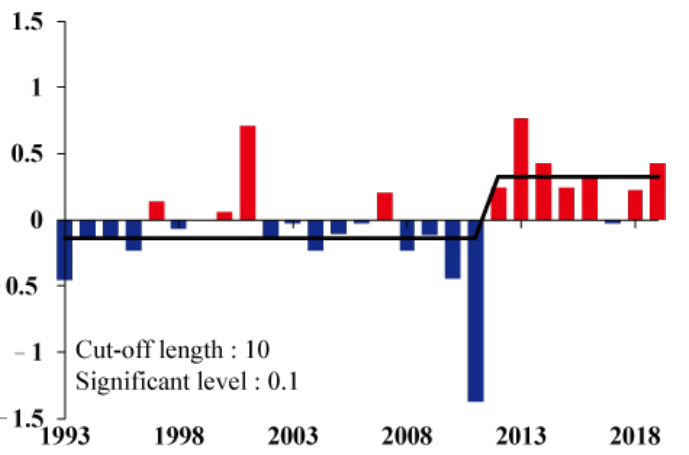
Figure 6. Long-term changes in East Korea Warm Current intensity in February. Black line represents step changes estimated using sequential t -test analysis of regime shifts analysis. Table 1. Correlation coefficient between volume transport in western channel of Korea Strait and Kuroshio Current intensity.